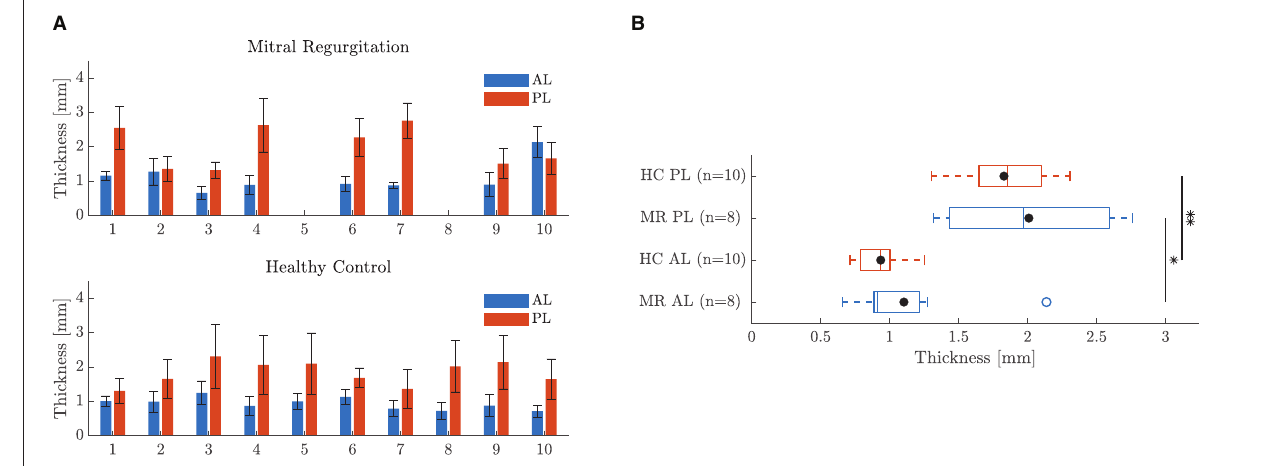
FIGURE 3 | Thickness of the leaflet samples. (A) Bar chart of the thickness map of each leaflet sample: anterior leaflet (AL), posterior leaflet (PL). Data are represented as mean standard deviation of the height map obtained by the Keyence microscope. (B) Boxplot of the mean sample thickness of all leaflet samples per group. The ± mean value of each group is marked with •. *Indicates a statistically significant difference ( p < 0.05) and ** a highly statistically significant difference ( p <